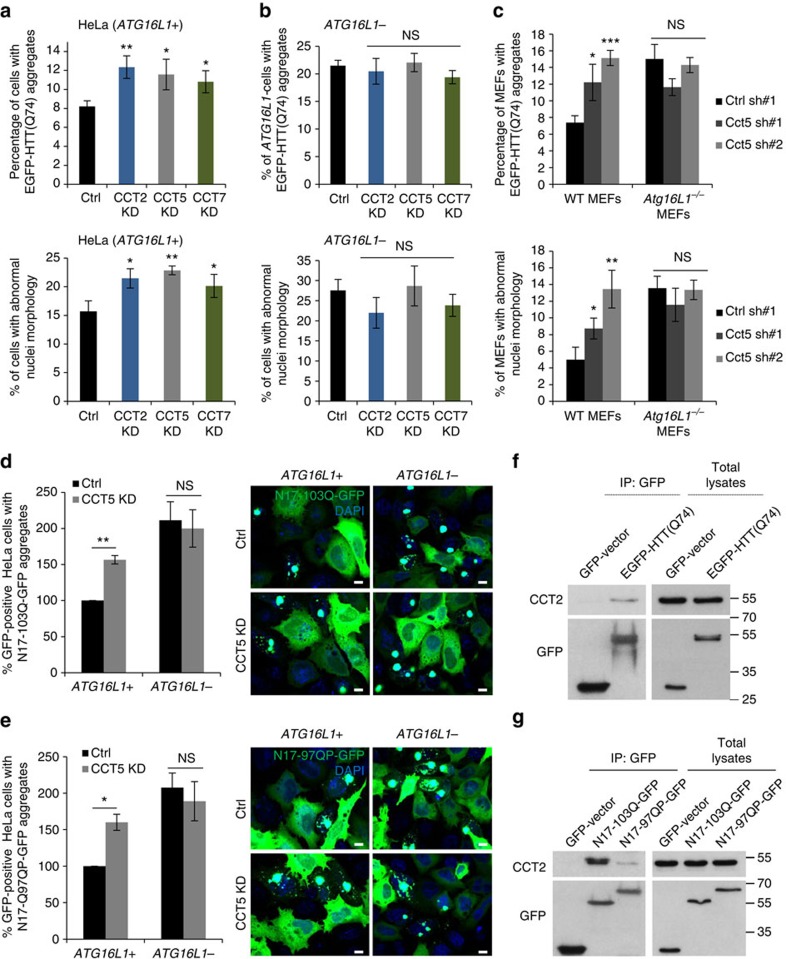
CCT depletion increases PolyQ aggregation consequently to reduced autophagic clearance.(a) EGFP-HTT(Q74) aggregation and cell toxicity in CCT-depleted HeLa cells. Upper: HeLa cells (ATG16L1+) were seeded on coverslips in triplicates, transfected with siRNAs targeting control or individual CCT subunits, followed by 1 μg of EGFP-HTT(Q74) overexpression. Bottom: percentage of nuclei with morphological changes (fragmented or condensed nuclei). Bars—means of percentages of cells with aggregates±s.d. (n=3; **P<0.01; *P<0.05; two-tailed t-test). Similar results were observed in four independent experiments. See Supplementary Fig. 9b for representative images. (b) EGFP-HTT(Q74) aggregation and cell toxicity in ATG16L1− CRISPR/Cas9 HeLa cells. The experiment was performed in parallel with a. Bars—means of percentages of cells with aggregates±s.d. (n=3; NS, not significant; two-tailed t-test). Similar results were observed in four independent experiments. See Supplementary Fig. 9b for representative images. (c) EGFP-HTT(Q74) aggregation and cell toxicity in WT and Atg16L1−/− MEFs. Cells were seeded on coverslips in triplicates, transduced with lentiviral particles targeting control or the mouse Cct5 subunit (two independent shRNAs) and transfected with EGFP-HTT(Q74). Bars—means of percentages of cells with aggregates±s.d. (n=3; ***P<0.001, **P<0.01, *P<0.05, NS, not significant; two-tailed t-test). Similar data was achieved in 3 independent experiments. See Supplementary Fig. 9a for representative images. (d) N17-103Q-GFP aggregation in CCT-depleted ATG16L1+ and ATG16L1− HeLa cells. Representative images of N17-103Q-GFP aggregates are displayed on right. Bars—mean of the percentages of cells with aggregates±s.e.m. (n=4 independent experiments, each performed in triplicates; **P<0.01, NS, not significant; one sample t-test). (e) N17-97QP-GFP aggregation in CCT-depleted ATG16L1+ and ATG16L1− HeLa cells. Representative images of N17-103Q-GFP aggregates are on right. Bars—mean of the percentages of cells with aggregates±s.e.m. (n=4 independent experiments, each performed in triplicates; **P<0.01, NS, not significant; one sample t-test). (f) CCT co-immunoprecipitation with EGFP-HTT(Q74). HeLa cells were transfected with either GFP-vector or EGFP-HTT(Q74) for 16 h and GFP-tagged proteins were pulled-down with GFP-Trap. (g) CCT co-immunoprecipitation with N17-103Q-GFP and N17-97QP-GFP. HeLa cells were transfected with GFP-vector, N17-103Q-GFP or N17-97QP-GFP for 16 h and GFP-tagged proteins were pulled-down with GFP-Trap. Note: N17-103Q-GFP does not have the proline-rich domain, while N17-97QP-GFP has both N terminus and proline-rich domains of htt exon 1.